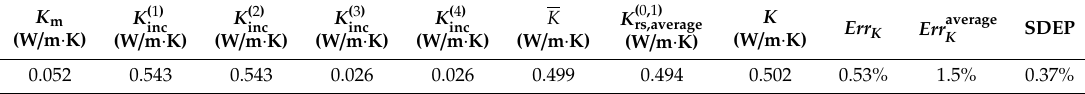
Table 6. The numerical result for the equivalent thermal conductivity of the